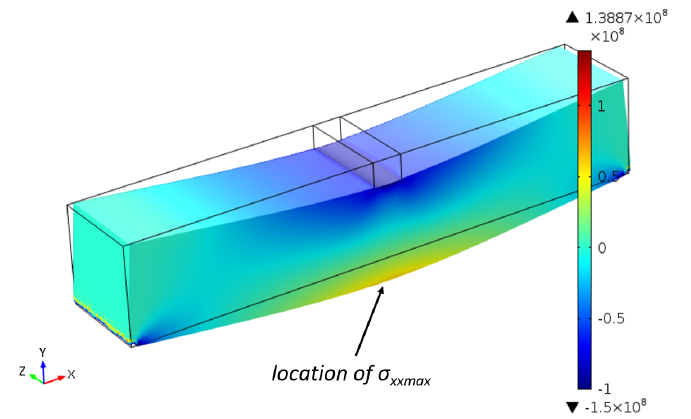
Figure 7. The σ distribution in the beam (unit for color scale bar: xx